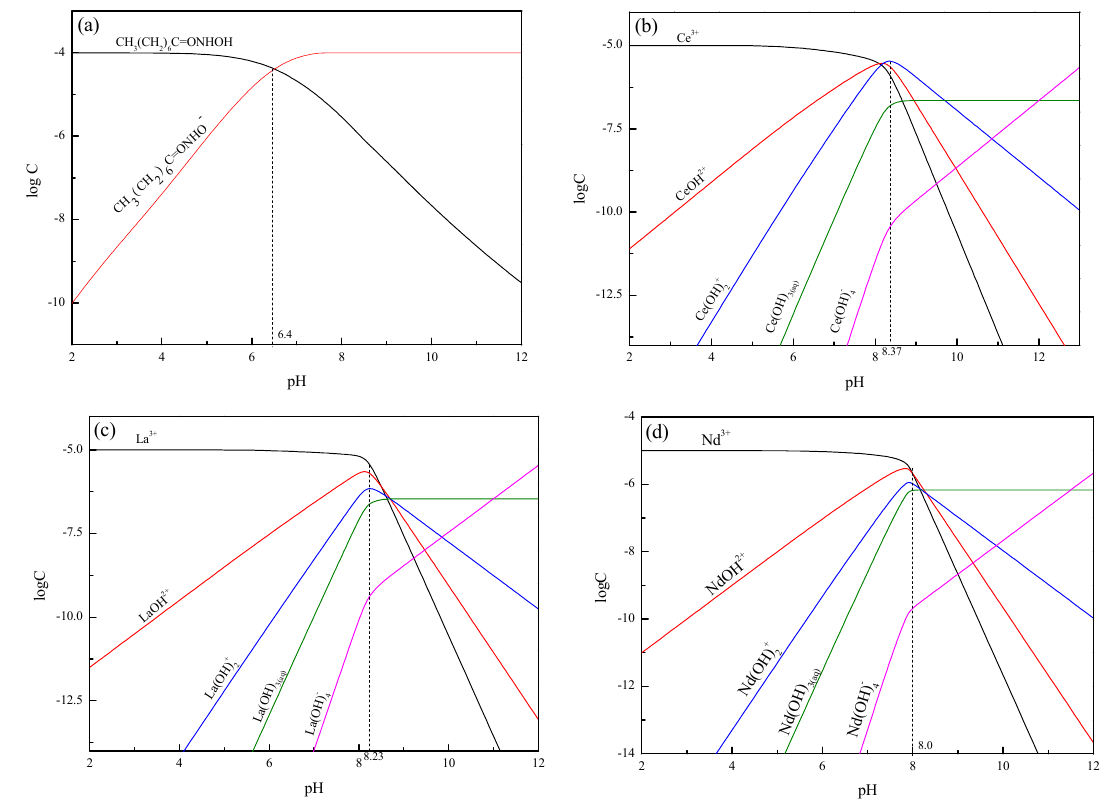
Figure 6. Logarithmic diagram of ( a ) SHA ( C = 2 × 10 − 4 M), ( b ) cerium ( C = 2 × 10 − 4 M), ( c ) lanthanum ( C = 2 × 10 − 4 M), and ( d ) neodymium ( C = 2 × 10 − 4 M).